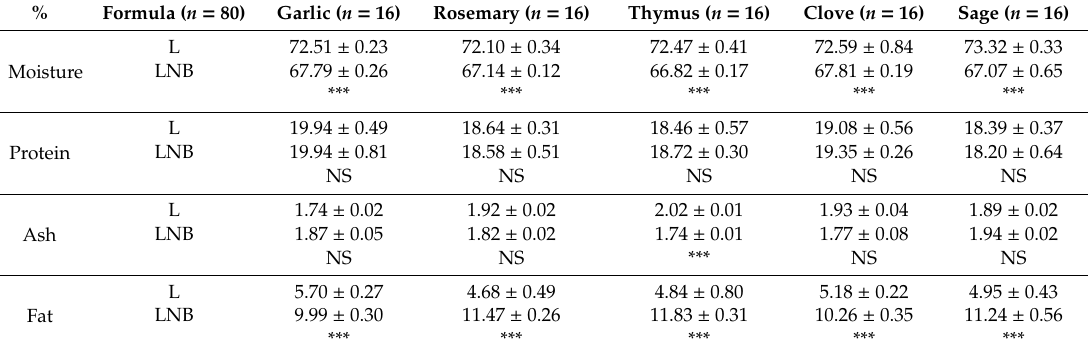
Table 1. Proximal composition (%; mean ± s.e.) of spiced lamb meat burgers from two di ff erent formulation types packaged under aerobiosis